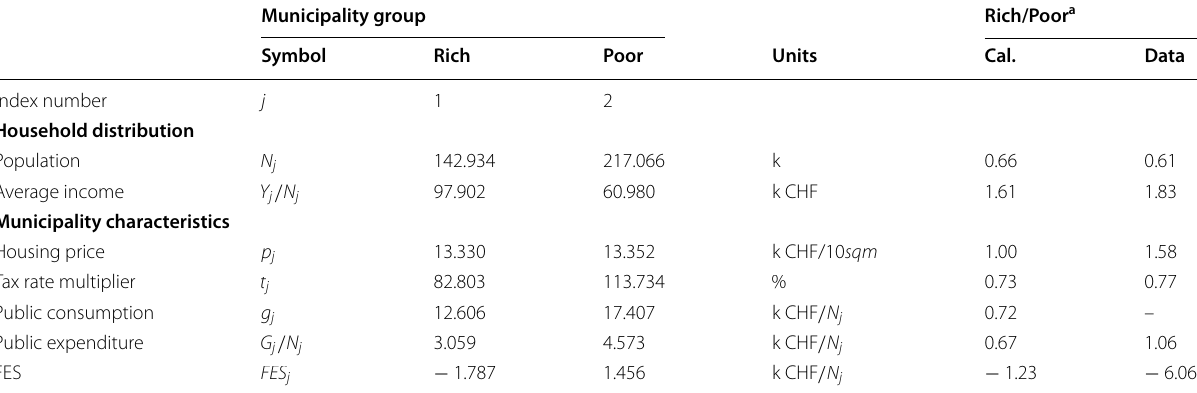
a “Cal.” refers to the baseline calibration presented here and “Data” are observed values from Table